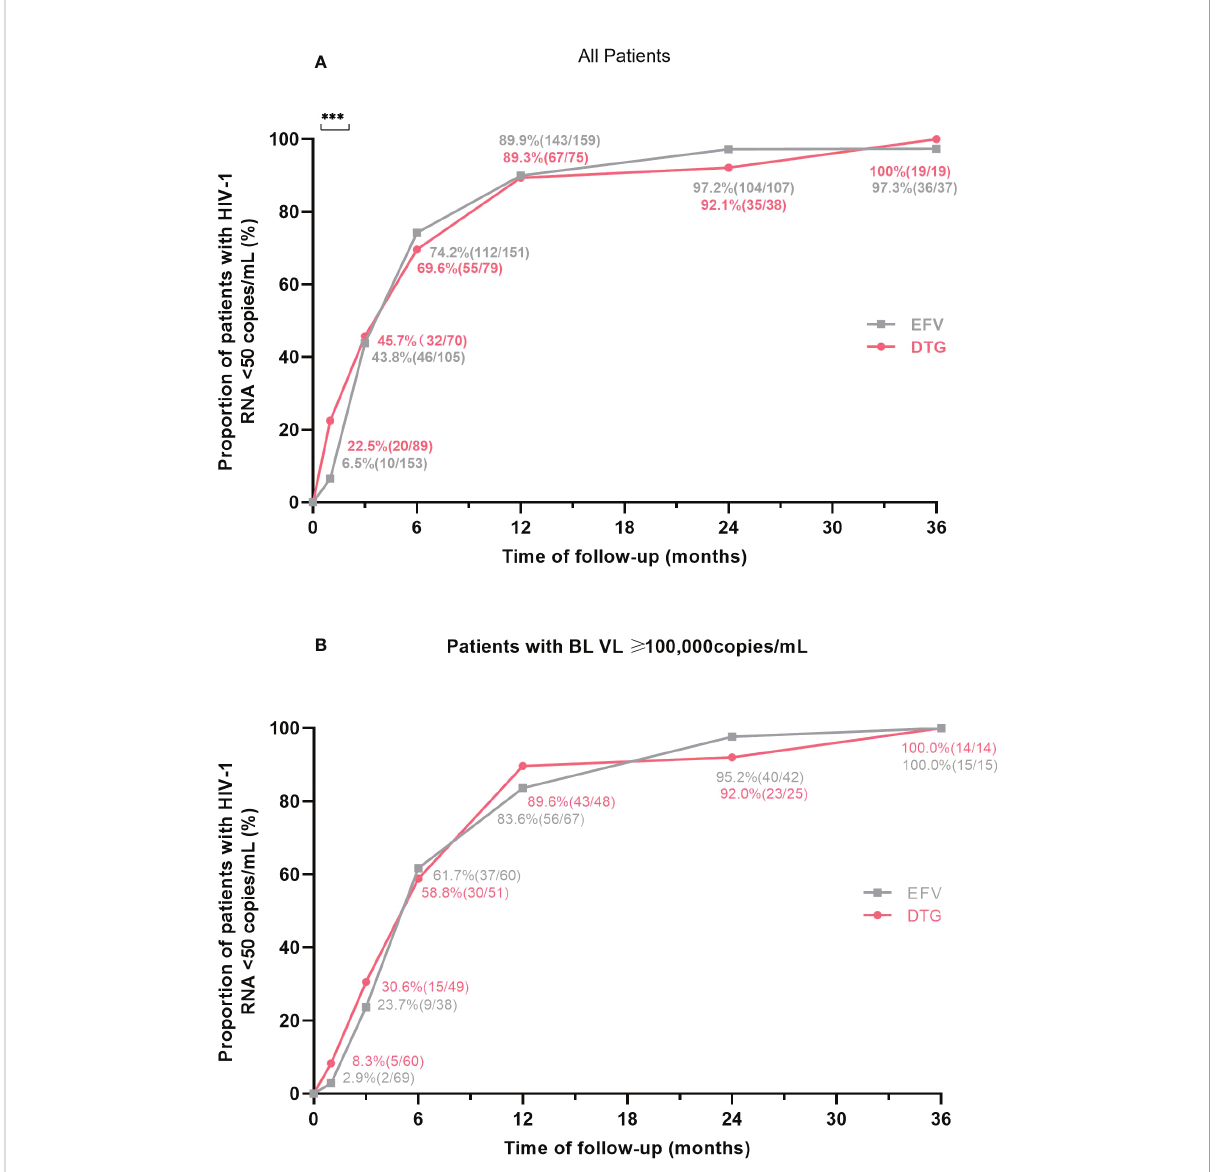
FIGURE 2 Proportion of patients with virological suppression at 6 different follow-up points according to antiretroviral regimens. (A) Proportion of virological suppression in all patients. (B) Proportion of virological suppression in patients with a baseline VL ≥ 100,000 copies/mL. BL, baseline; VL, viral load; EFV, efavirenz; DTG, dolutegravir.